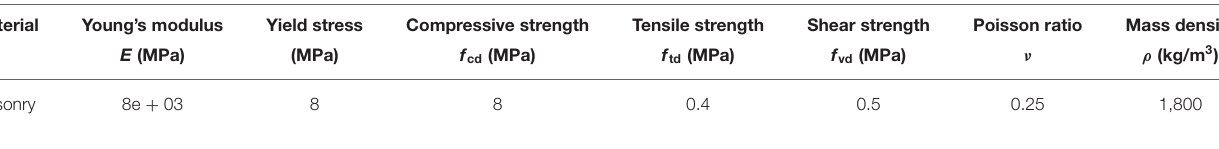
TABLE 1 | Mechanical properties of